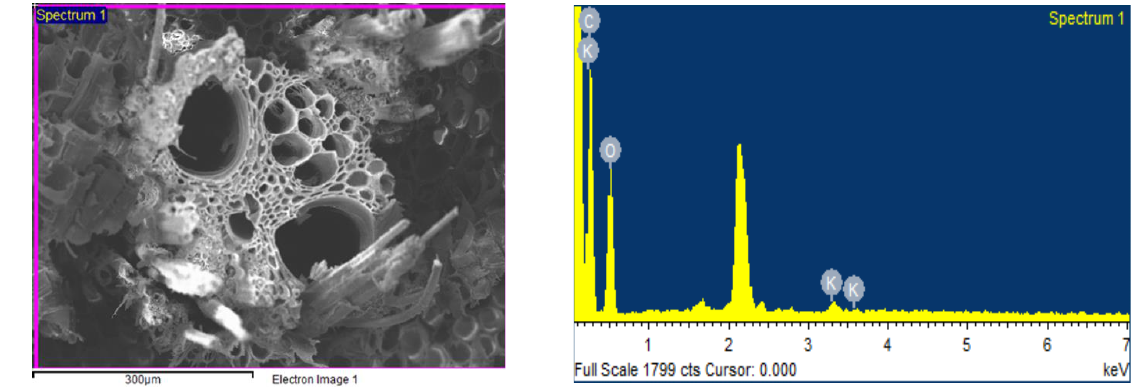
Figure 2. SEM and EDS images of the pore structure of disposable bamboo